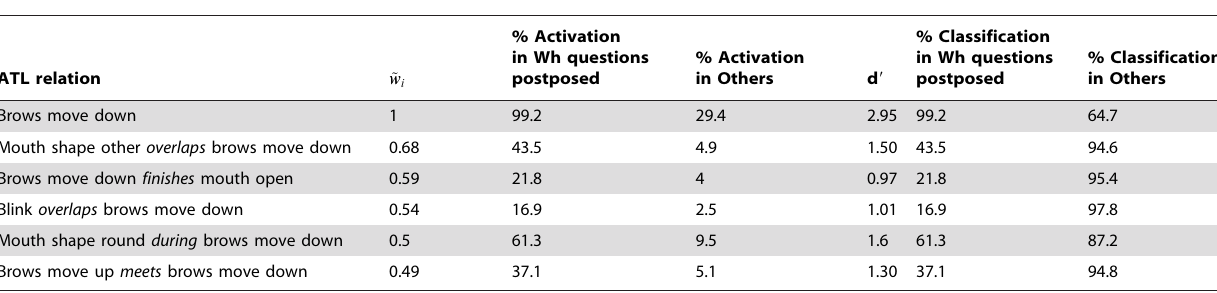
Table 5. Discriminant features for Wh-questions postposed.